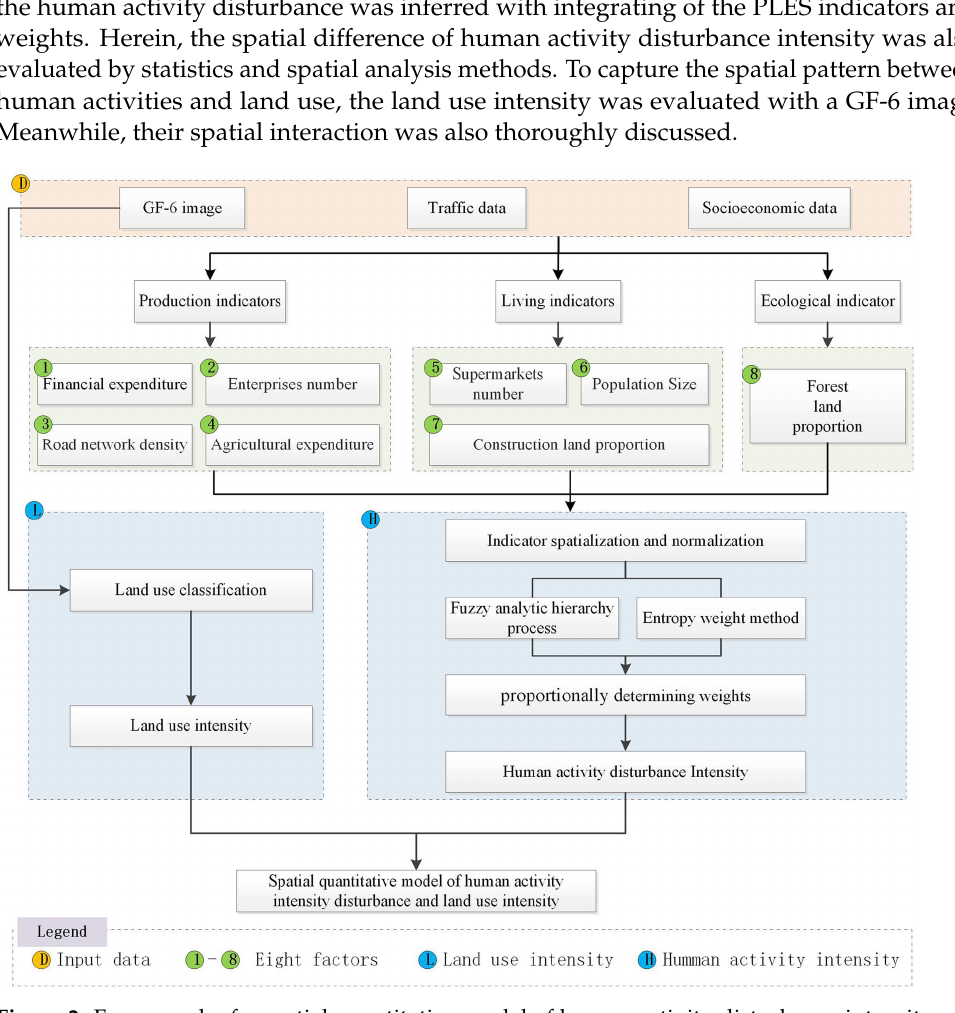
Figure 2. Framework of a spatial quantitative model of human activity disturbance intensity and land use intensity.